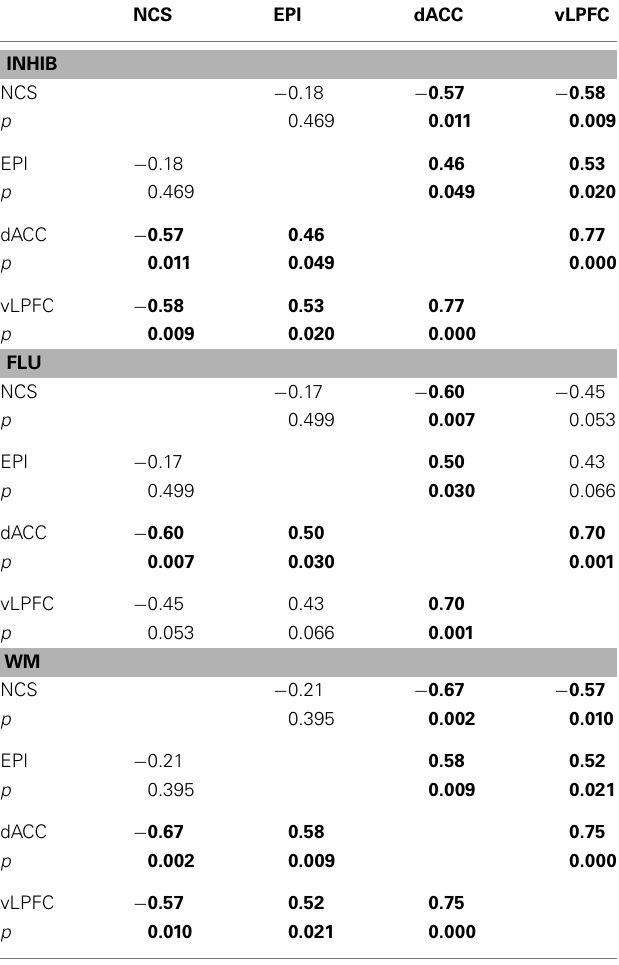
Table 5 | Partial correlations between brain activity, self-concept, and episodic score, controlling for executive functions